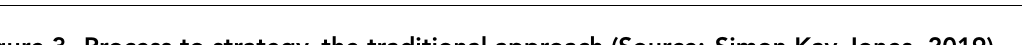
Figure 3. Process-to-strategy, the traditional approach (Source: Simon Kay-Jones,